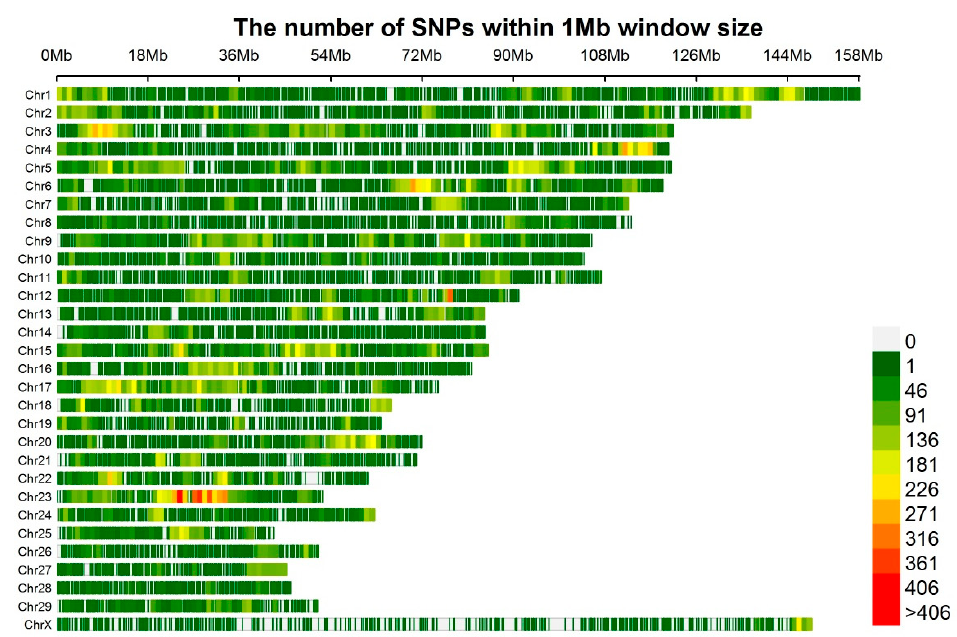
Figure 1. Density of single nucleotide polymorphisms (SNPs) on each chromosome after quality control.